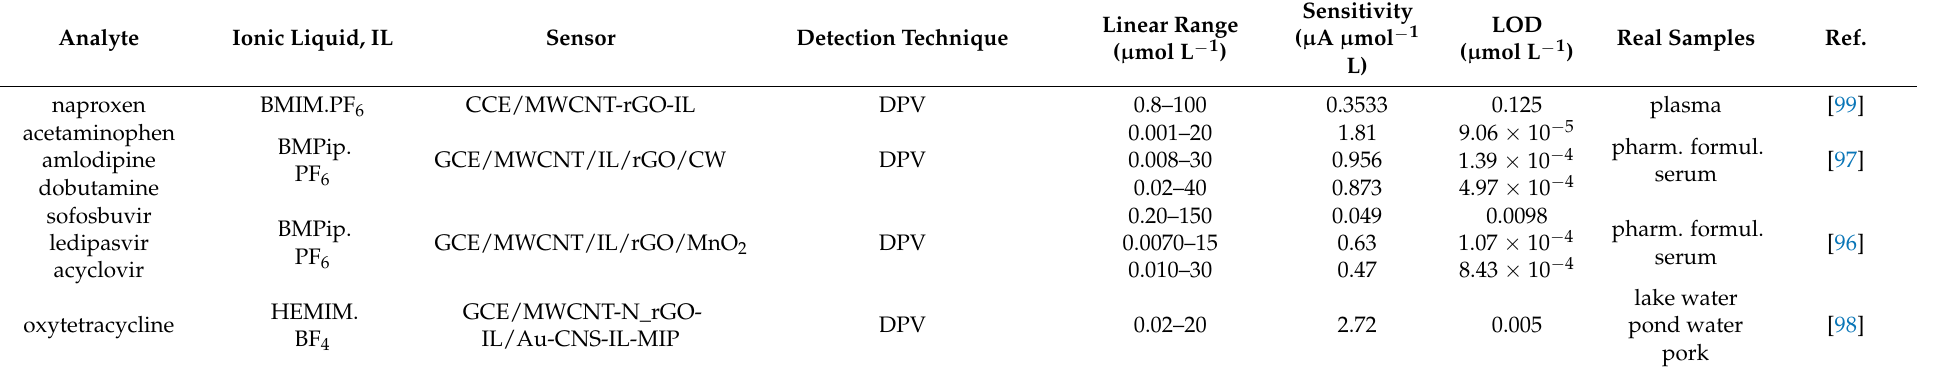
Table 3. Sensors based on a combination of graphene and MWCNT in the IL nanocomposite for pharmaceutical analysis.